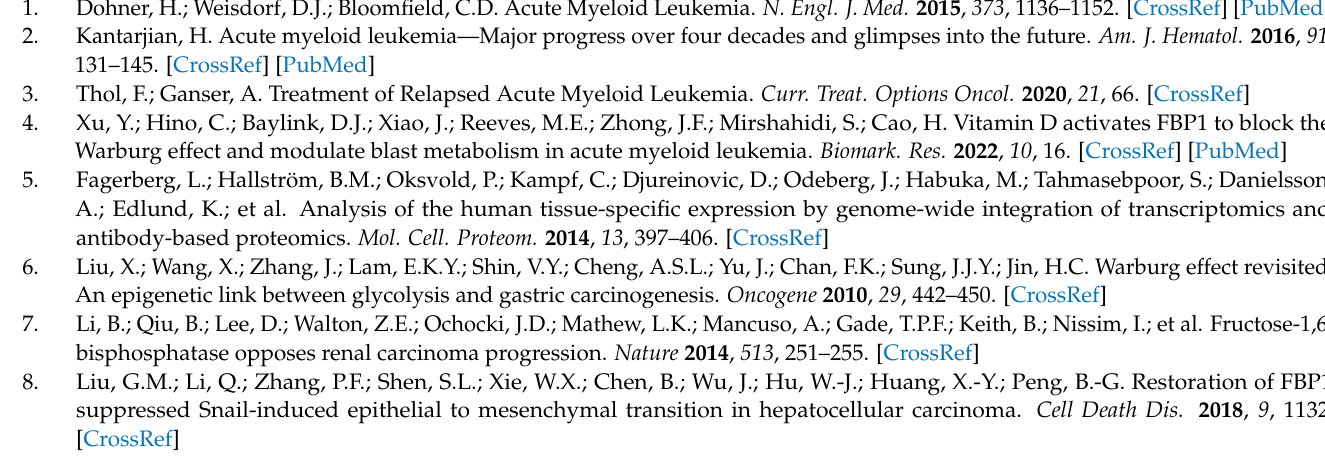
Table S2: List of Primers (Origene, etc.) used in this study; Figure S1. GFP expression in different MV4-11 cell lines in